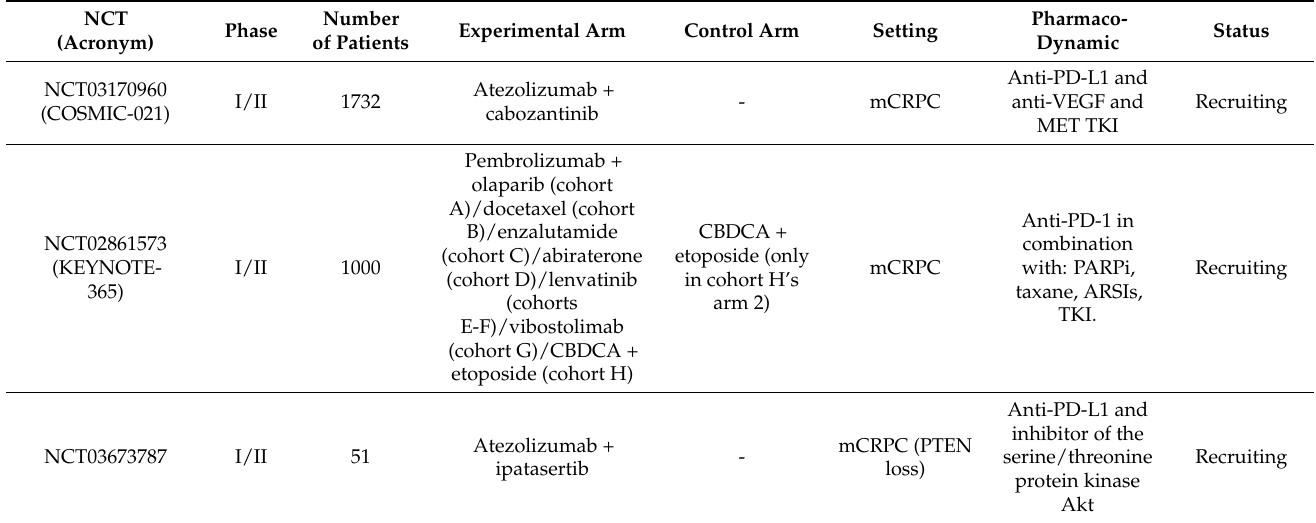
Table 3. Ongoing clinical trials evaluating various immuno-combination-based approaches in advanced prostate